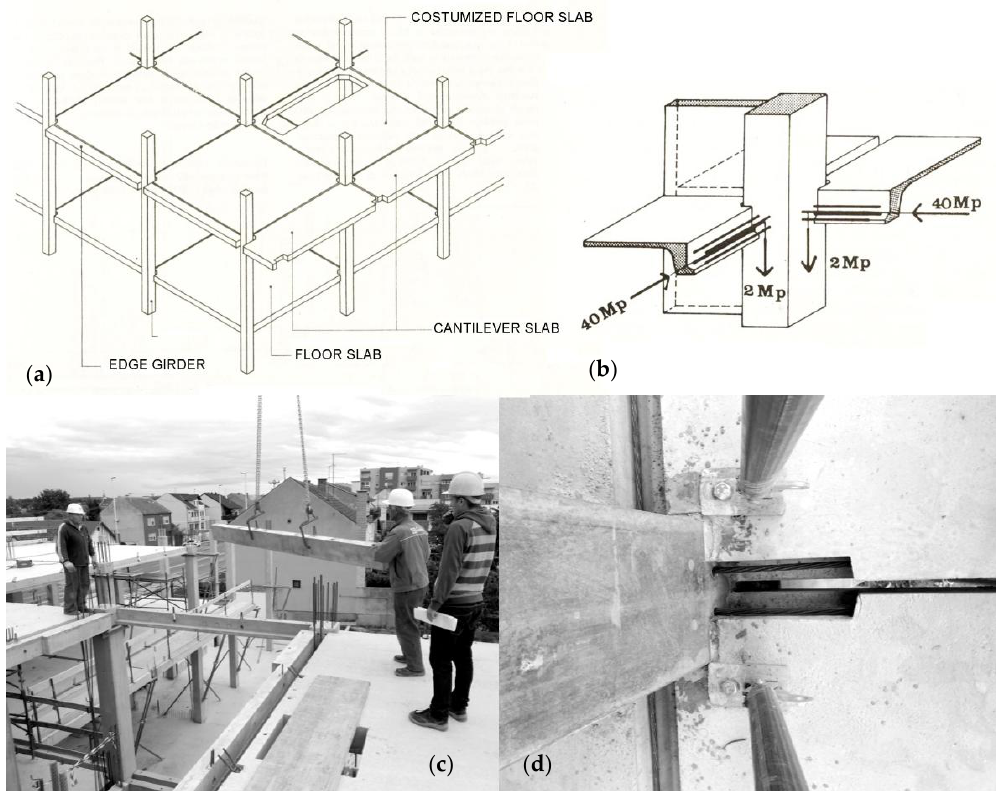
Figure 3. IMS system: ( a ) Skeleton fame consists in concrete column, prestressed beams, cantilever slab, edge rib; ( b ) Column-slab joint; ( c ) Top view of standard floor slab; ( d ) Steel tendons are visible already post-tensioned and awaiting the casting of concrete for system girder [21].